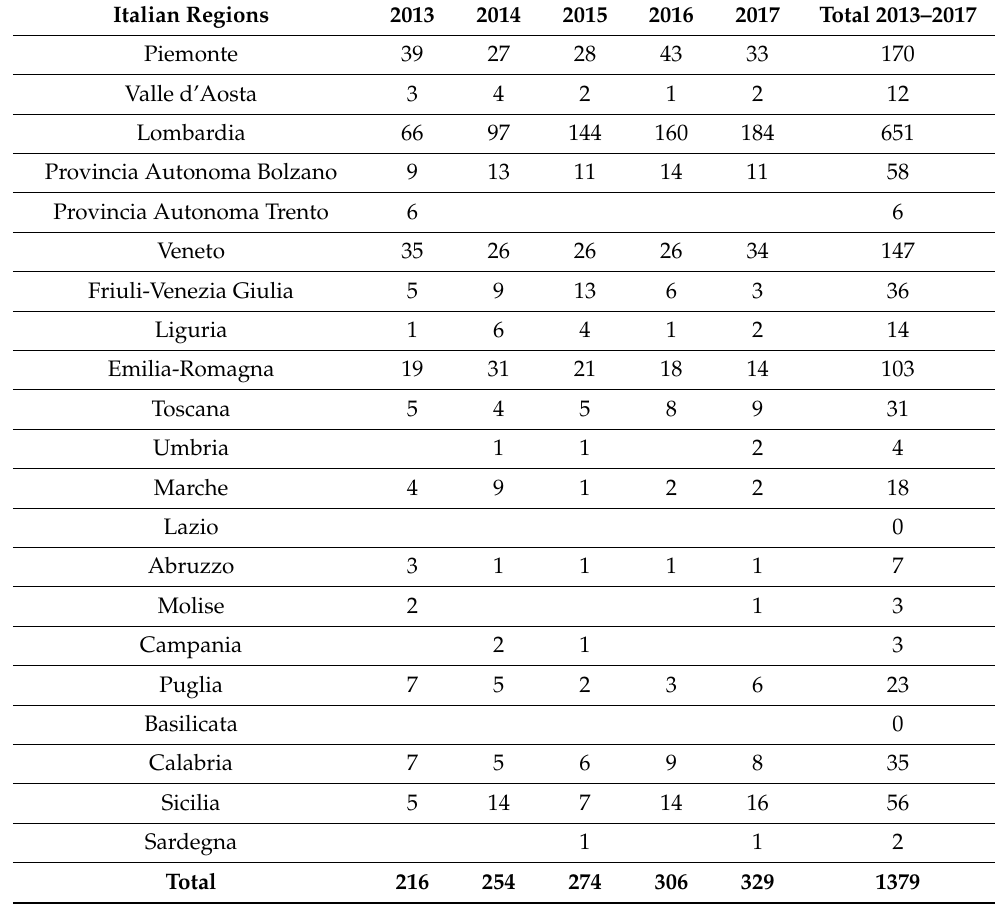
Table 1. Newborns with